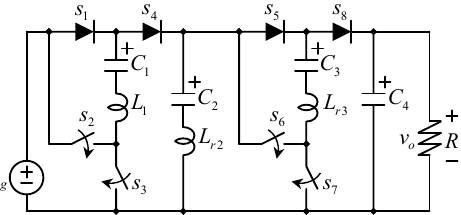
Figure 30. A resonant version of the converter in Figure 9.